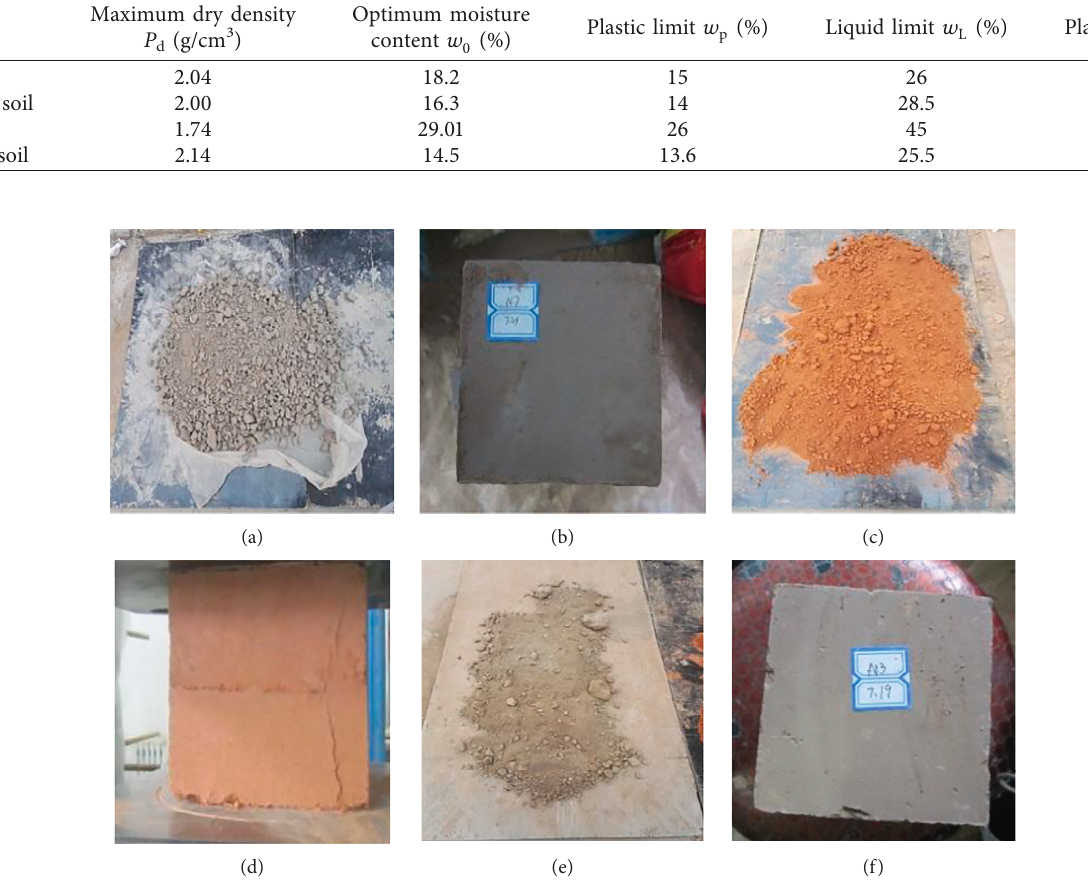
Figure 1: Manufacturing equipment and test specimen. (a) Schematic diagram of device. (b) Specimen making. (c) Specimen. Table 1: The index of soil-based materials from different regions.